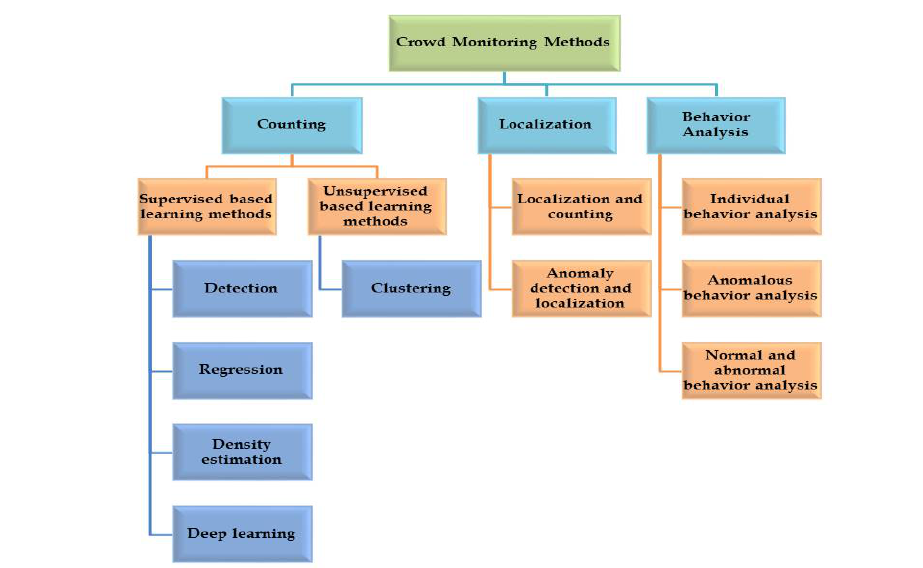
Figure 5. Crowd monitoring methods reported in